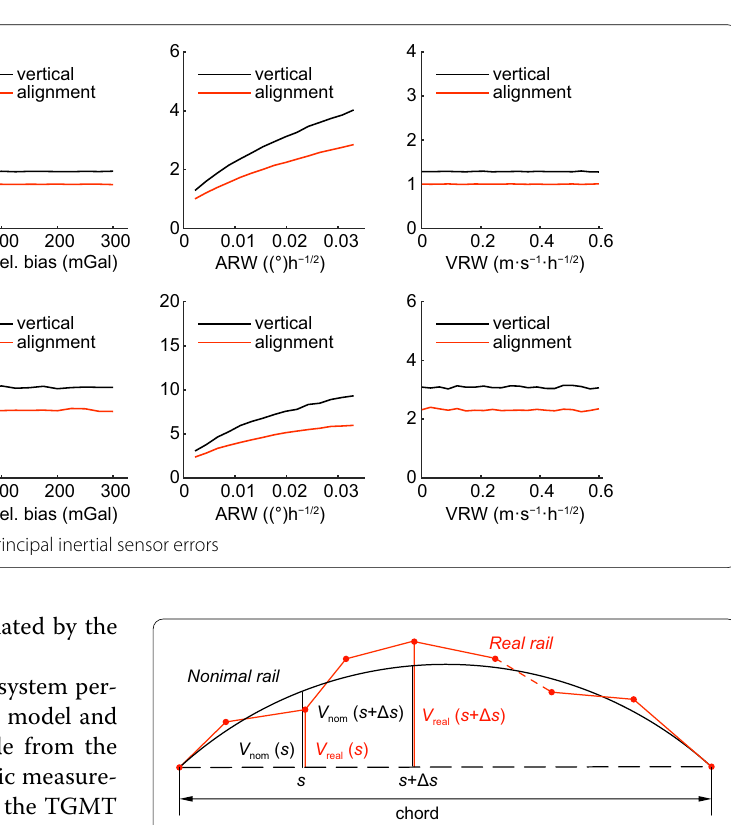
Fig. 9 Illustration of the track irregularity